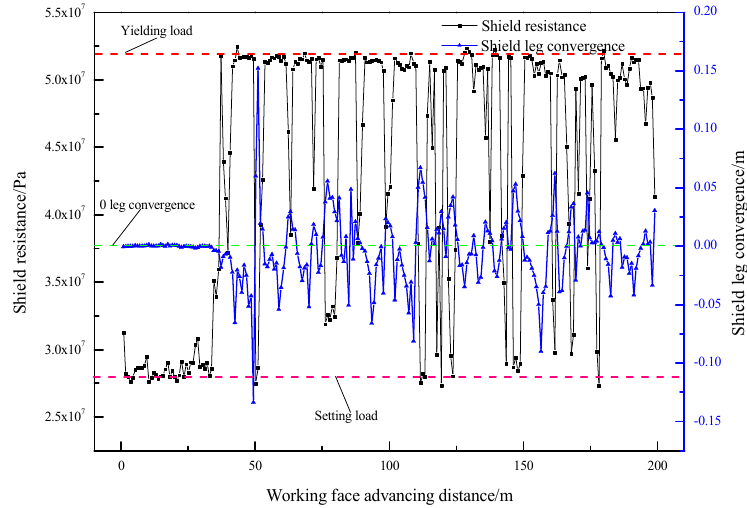
Figure 12. Changes of shield resistance and leg convergence under 7.0 m mining height.